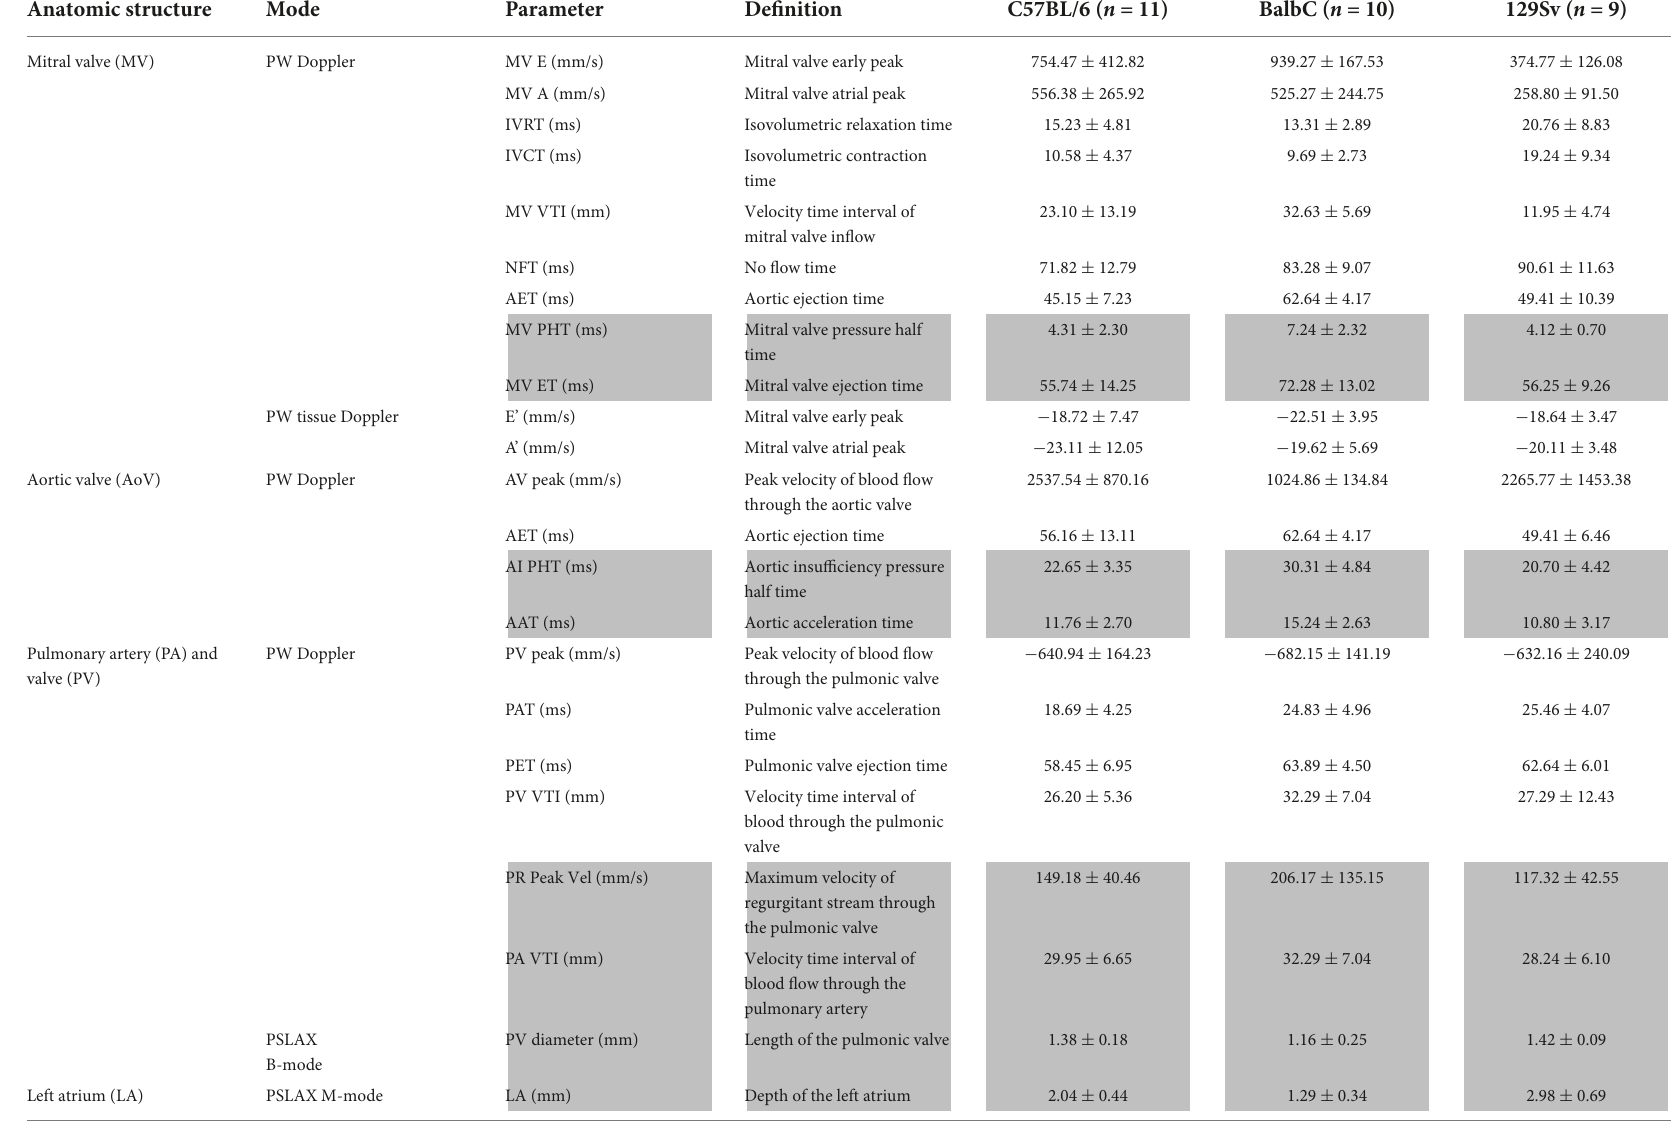
TABLE 1 Anatomic structures, modes, definitions, and reference values of both common and infrequently used parameters for the C57BL/6, BalbC, and 129Sv mouse